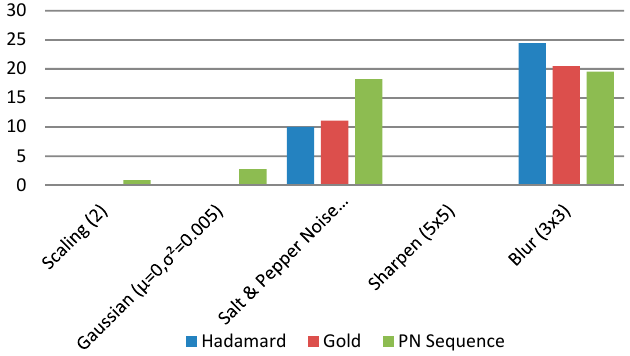
Figure 12. BER after different attacks in the case of different types of spreading codes.